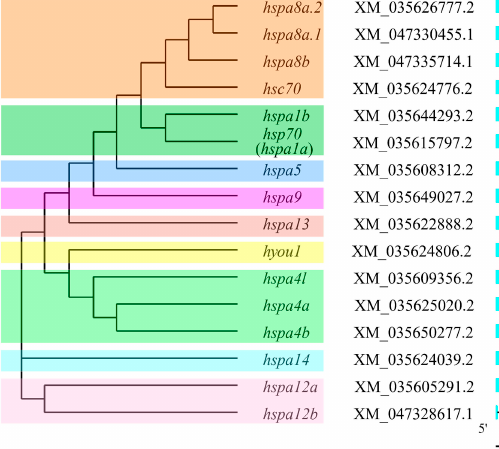
Figure 4. The combination of phylogenetic relationship and conserved motifs. The left of the graph shows the phylogenetic relationships of S. maximu HSP70 genes. The right of the graph shows the distribution of conserved motifs and each colored rectangular box represents a motif. 2.5. Subcellular Localization and Protein Structure Analysis The prediction of subcellular localization indicated that most HSP70 proteins in the turbot were located in the cytosol and extracellular space; however, the proteins encoded by hspa9 , hspa12b , and hyou1 were localized in the mitochondria, nucleus, and endo- plasmic reticulum, respectively (Table 3). Moreover, the secondary structure prediction showed that turbot HSP70 proteins were primarily composed of alpha helices (32.39–50.51%) and random coils (29.61–44.48%), while extended strands and beta turns accounted for 12.37–23.72% and 3.31–7.37% of the structure, respectively (Table 3). In addition, the signal peptide prediction results demonstrated that only hyou1 and hspa5 encoded proteins with Sec/SPI signal peptides with SP values of 0.995566 and 0.999579,